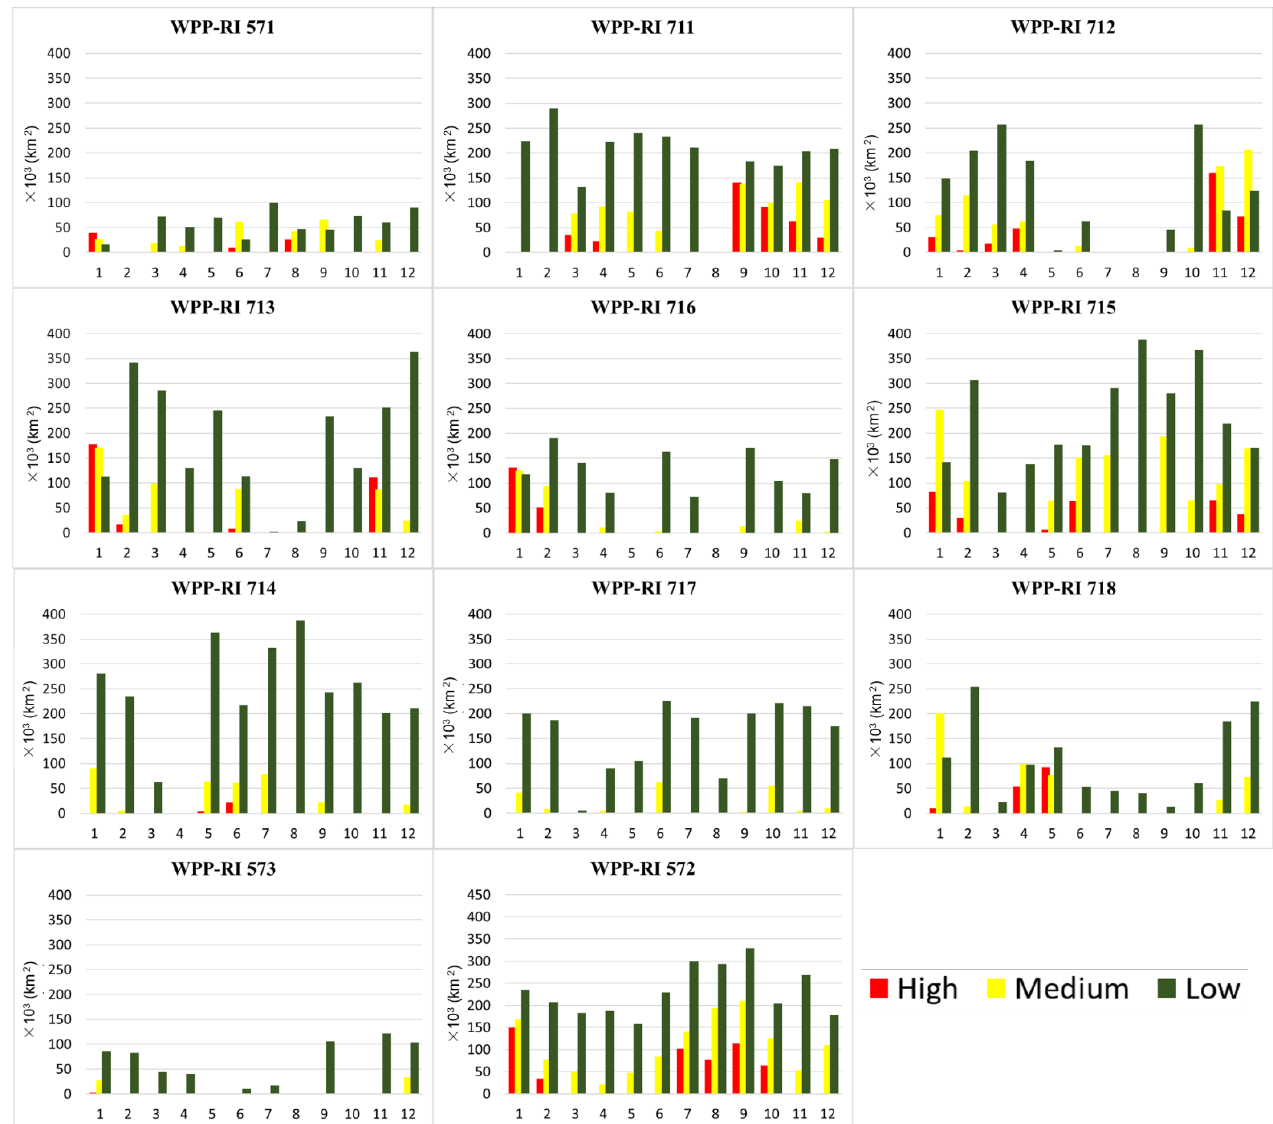
Figure 6. Monthly potential fishing zone extents in Indonesia for high, medium, and low classes.